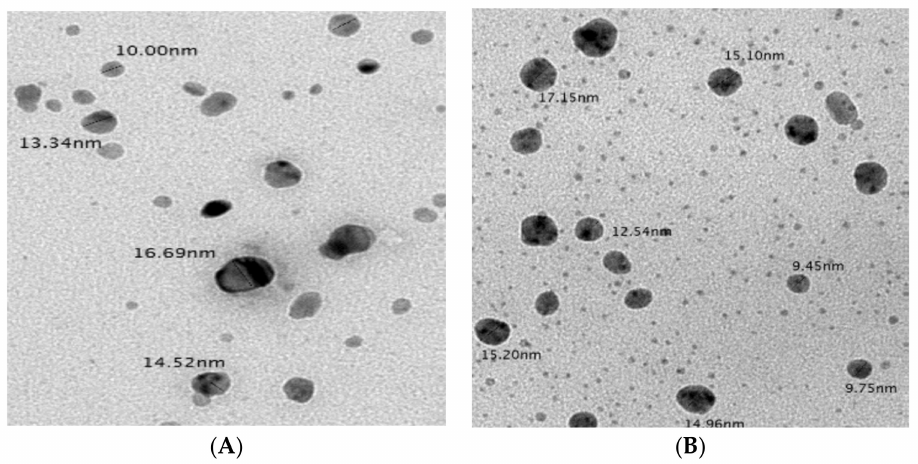
Figure 8. TEM micrographs of optimized biosynthesized AgNPs showing a spherical shape of nanocolloids and their size distribution ranges. ( A ) AgNPs biosynthesized using pomegranate peel extract ( B ) AgNPs biosynthesized using orange peel extract. Bar = 100